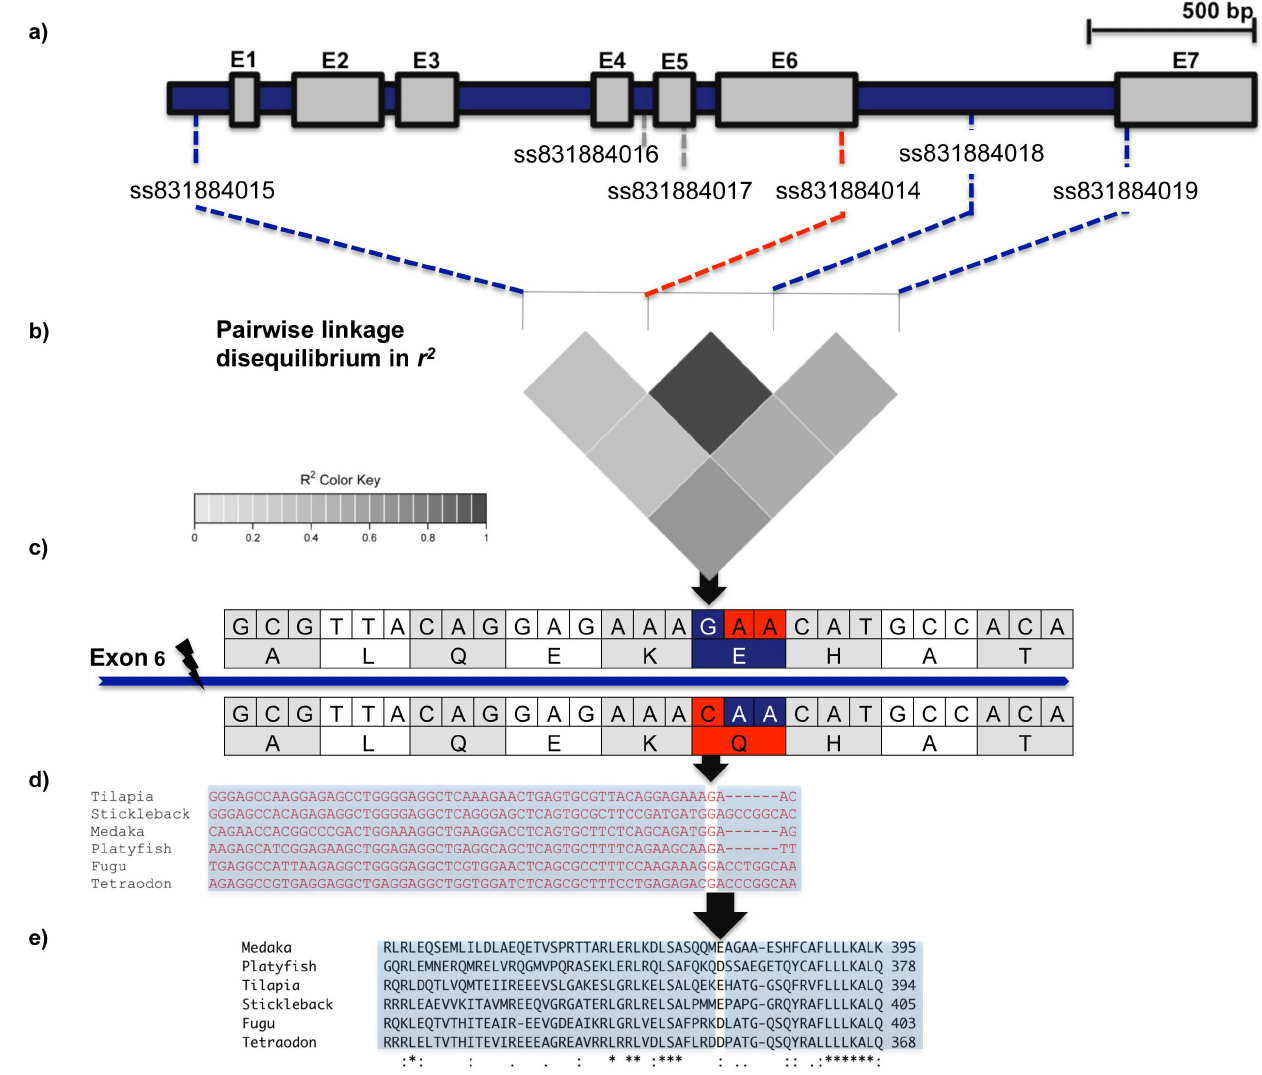
Figure 2. Gene structure, pairwise linkage disequilibrium ( r 2 ) between SNPs, and functional annotation of the Nile tilapia amh gene derived from the Ensembl database. a) Gene structure of the amh gene derived from Scaffold GL831234.1 . Exons 1–7 (E1–7) are represented by filled grey boxes. Blue and red dashed lines show positions of polymorphic SNPs in the amh gene. SNP ss831884015 (C . T) is located 2 225 bp upstream of the start codon ATG, SNP ss831884018 was located in the intron between exon 6 and 7. Variants ss831884014 and ss831884019 were found in exons 6 and 7. SNP ss831884014 (G . C) and ss831884019 (C . T) were missense mutations leading to amino acid changes from glutamic acid to glutamine (codons Gaa/Caa) and alanine to valine (codons gCg/gTg). Table 1 deals with the functional annotation of all six SNPs. b) Pairwise linkage disequilibrium heat map of four polymorphic allelic variants in the Nile tilapia amh gene. c) Partial DNA to protein translation of exon 6 in the Nile tilapia amh gene, depicting a non-synonymous amino acid substitution at position 376 of the putative amh -protein (indicated by black arrow) coded by an allelic variant ss831884014 of scaffold GL831234.1 . d) Partial comparative alignment of the amh genomic exon 6 sequences for six teleost species derived from the Ensembl database. e) Partial comparative alignment of the amh protein sequence for six teleost species derived from